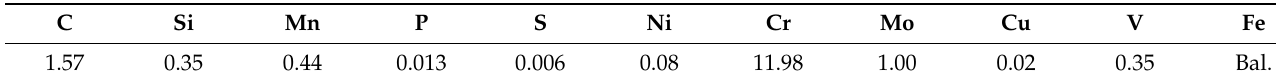
Table 3. Fe alloy powder composition data from [19].